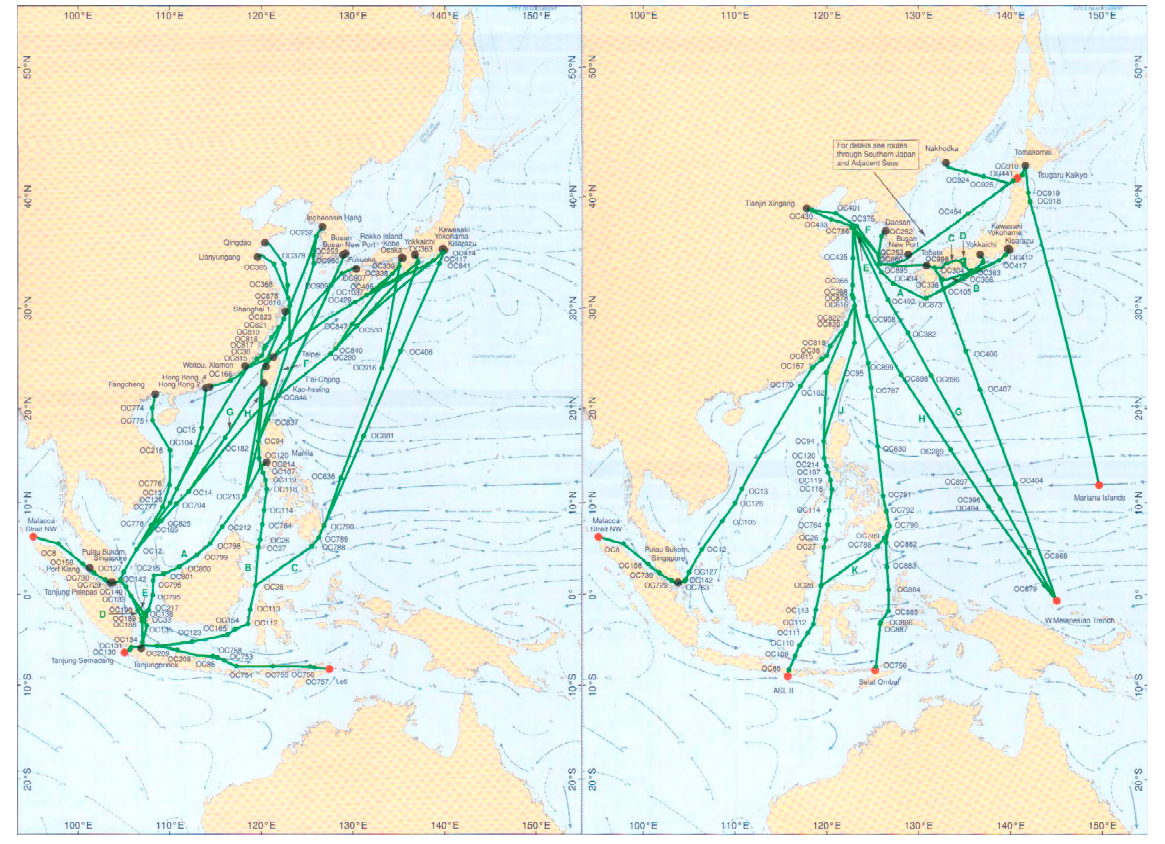
Figure 11. Some routes in the Taiwan Strait shown in the Ocean Passages for the World.